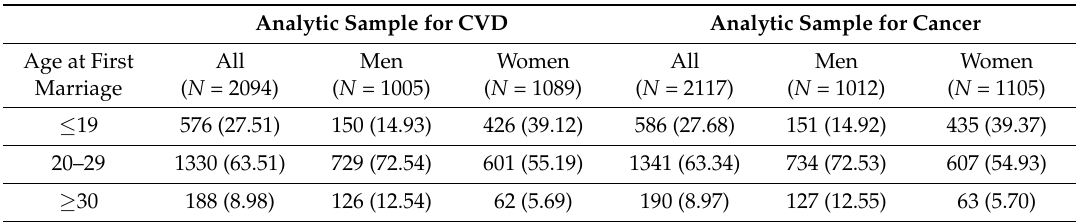
Table A1. Frequencies of Age at First Marriage Categories for Analytic Samples, N